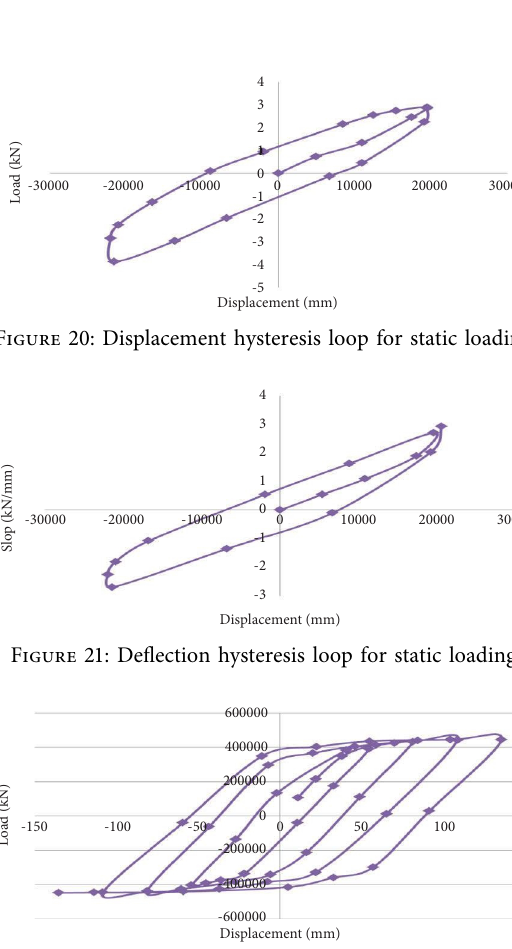
Figure 22: Displacement hysteresis loop for beam column joints.